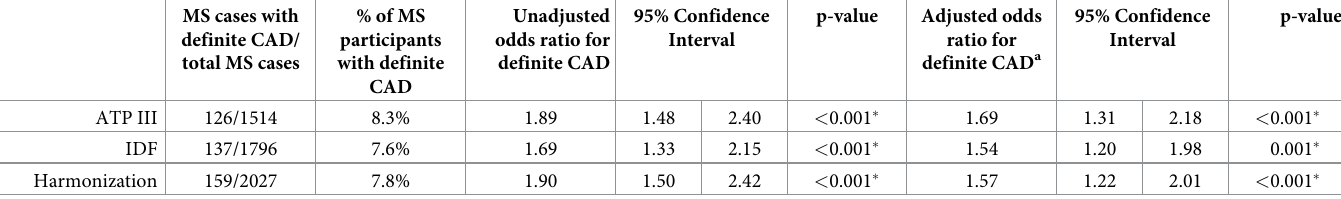
Table 7. Crude prevalence, unadjusted and adjusted odds ratios for definite coronary artery disease among participants with metabolic syndrome. MS cases with definite